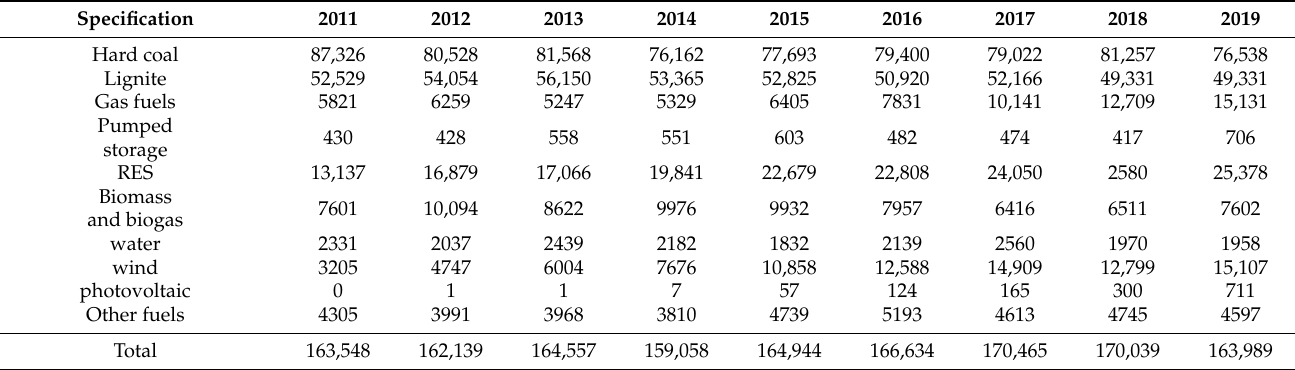
Table 1. Electricity generation by energy carrier.